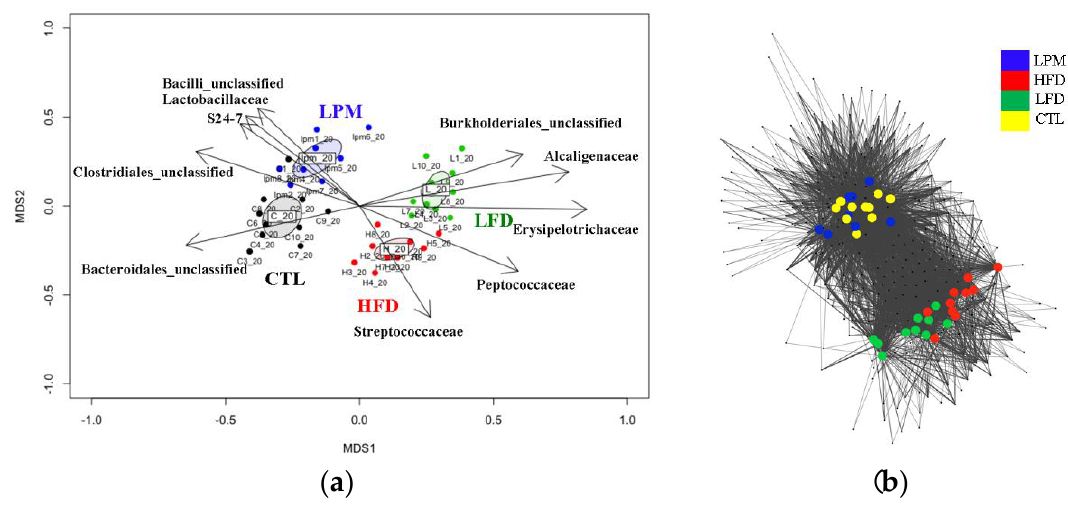
Figure 2. Comparison of mice gut microbiota across different treatments: ( a ) non-metric multidimensional scaling analysis; and ( b ) network analysis with operational taxonomic units (distance = 0.03).